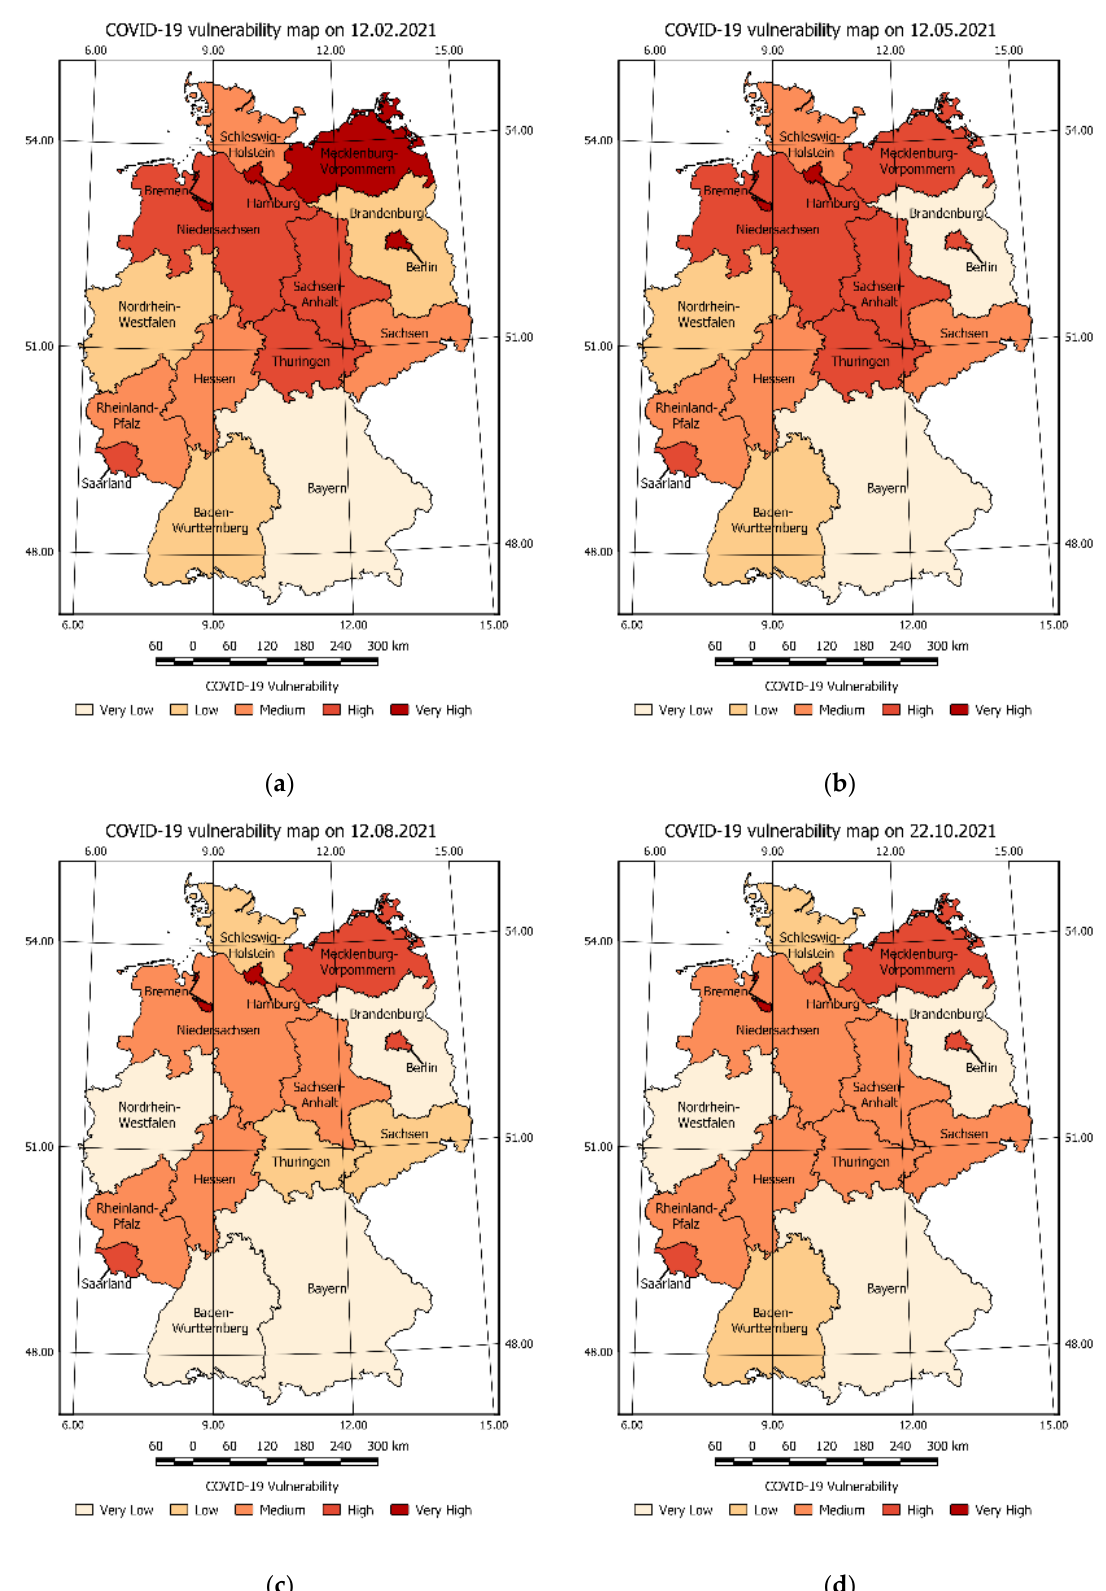
Figure A3. Sequence of CVI estimated in selected days: ( a ) 12 February 2021 ( b ) 12 May 2021 ( c ) 12 August 2021 ( d ) 22 October 2021.